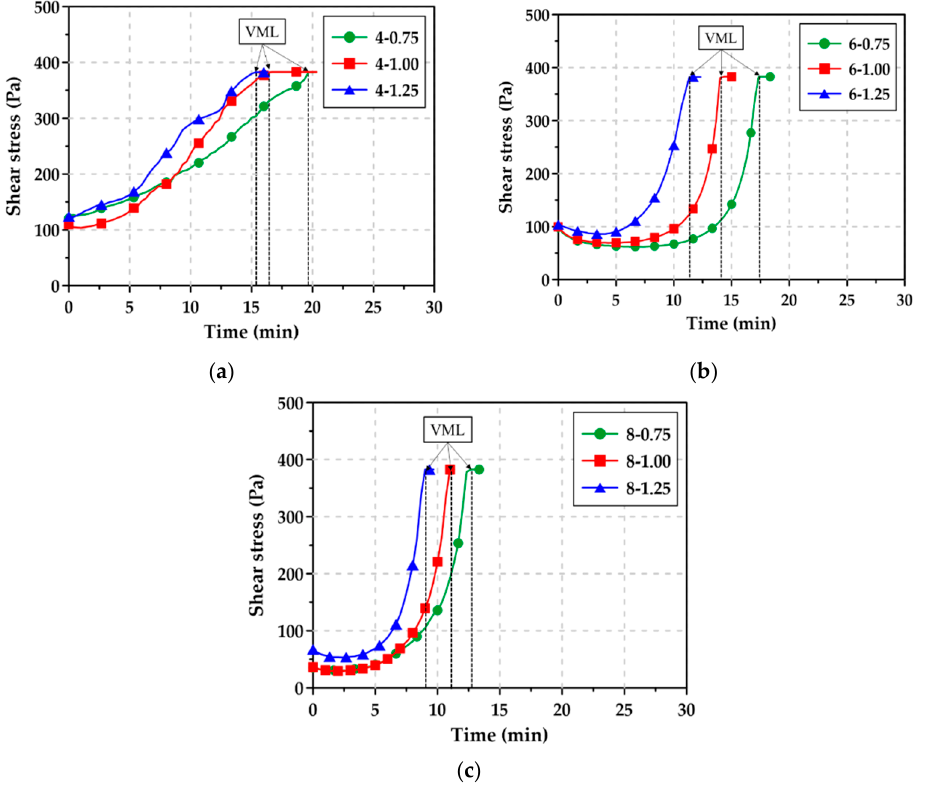
Figure 8. Rheology test curves for AAS pastes: ( a ) Na 2 O content = 4%, ( b ) Na 2 O content = 6%, ( c ) Na 2 O content = 8%.